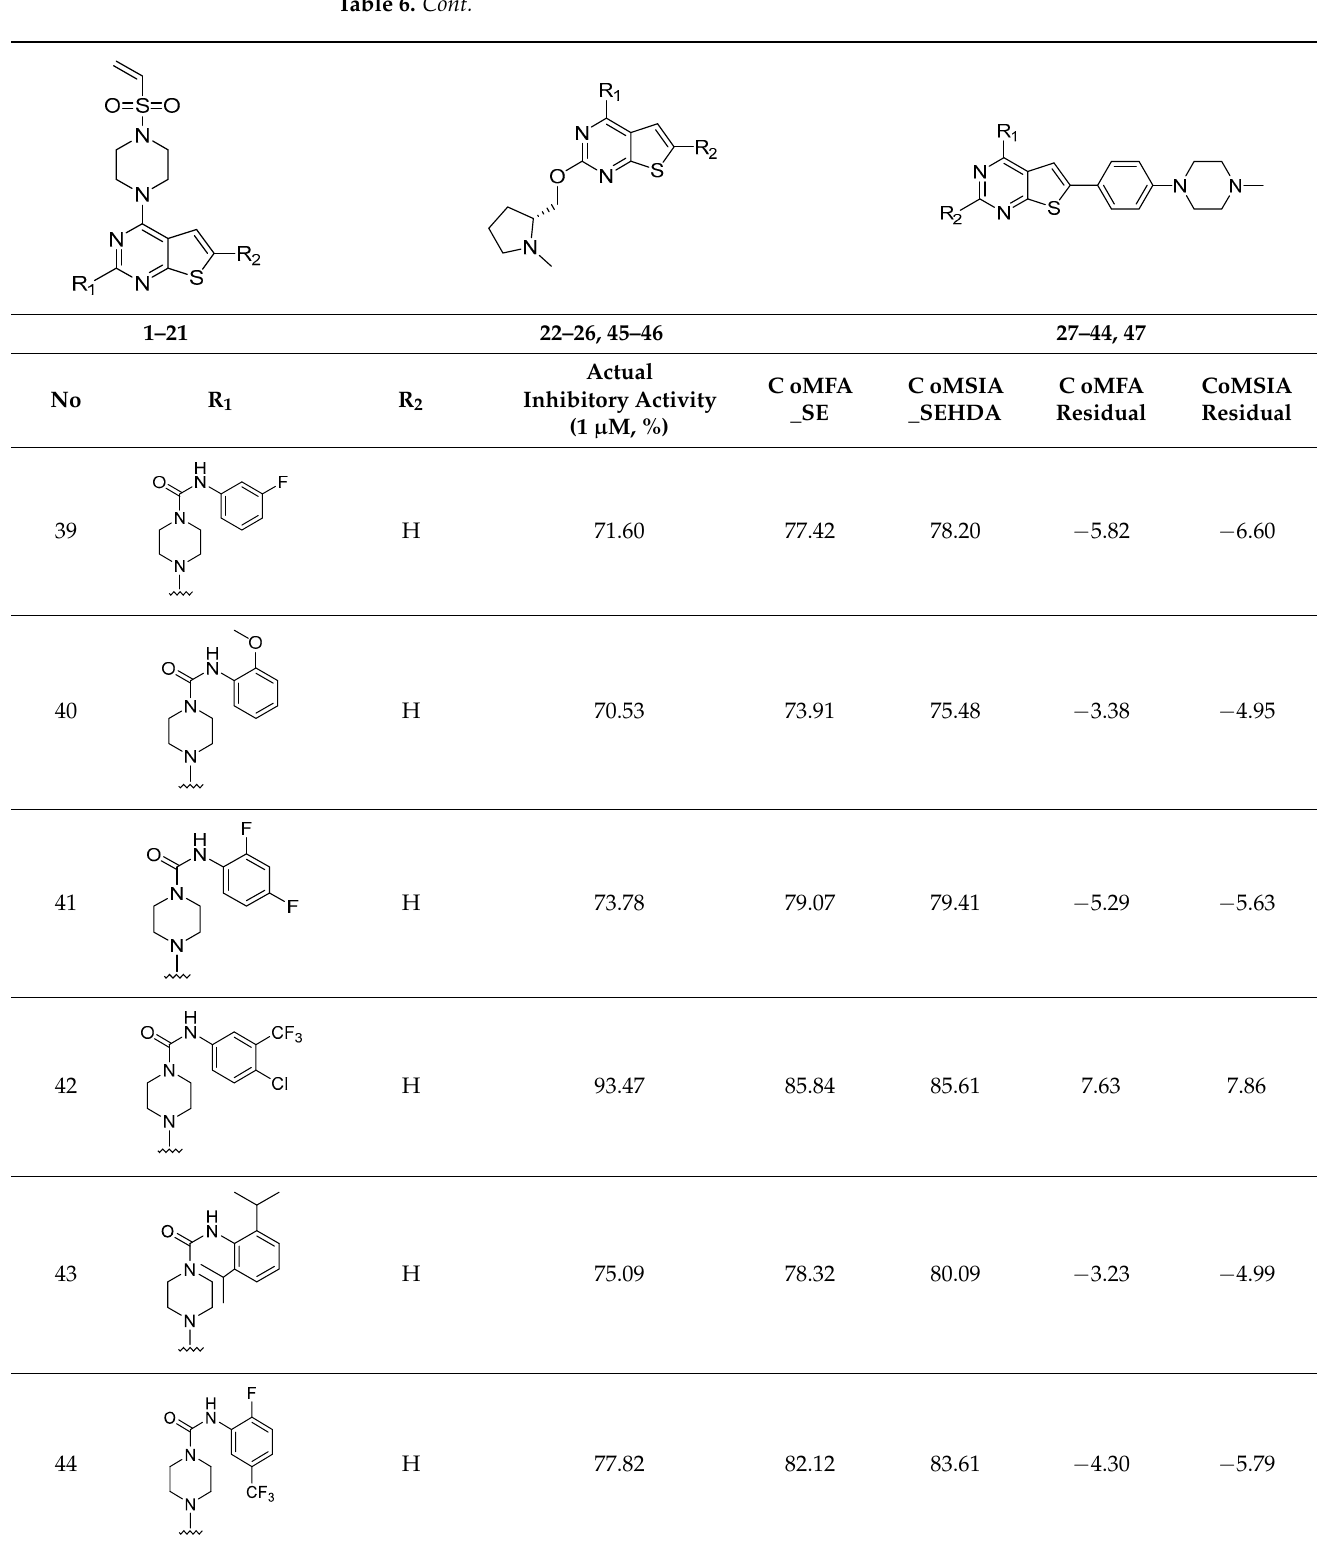
Table 6. Chemical structures and inhibitory activity values of thieno-pyrimidine derivatives. Table 6. Cont.